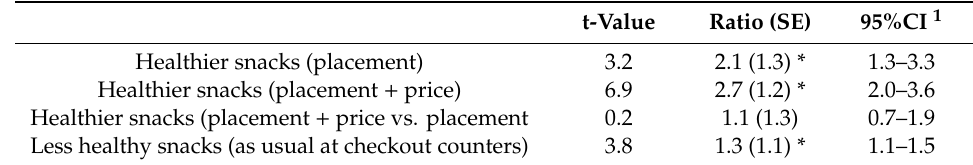
Figure 2. Median daily number of purchased snacks (per 1000 customers per day) of less healthy snacks, and healthier snacks separately during the placement intervention and healthier snacks during the placement + price intervention, during the in the control and intervention periods. Table 2. E ff ect of the Healthy Checkout Counter (HCC) intervention on the purchase of healthier snacks and less healthy snacks at checkout counters per 1000 customers per day (placement, placement + price intervention separately) between the intervention period and the control